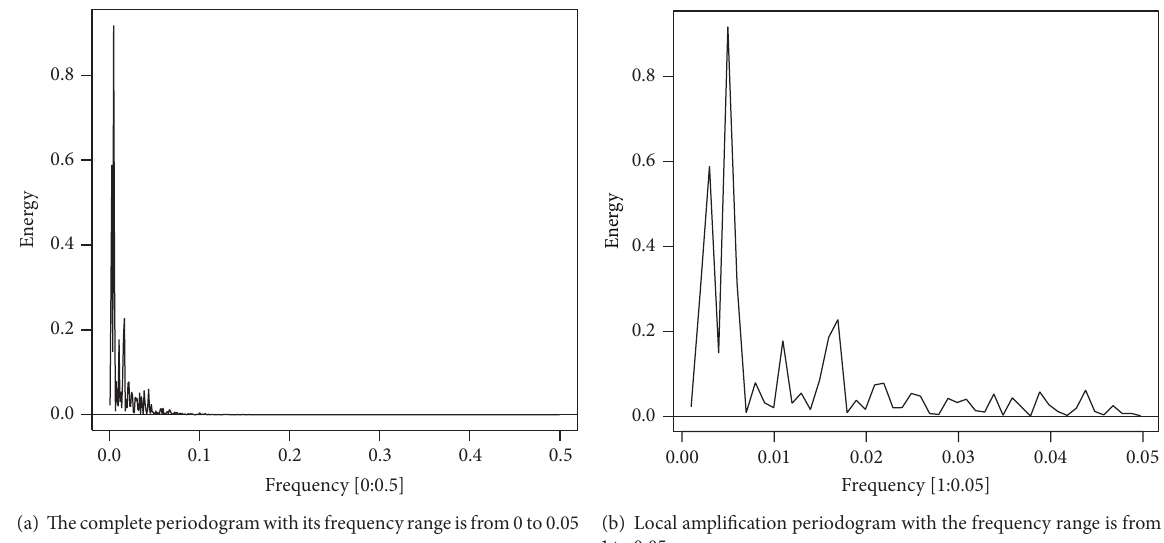
Figure 5: Periodogram of the popularity degree of college entrance examination subclass. Remark . 𝑥 -axis denotes the possible frequency of the popularity degree; 𝑦 -axis represents the energy of the corresponding